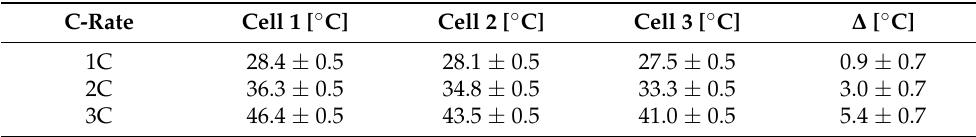
Table 8. Comparison of maximum cell temperatures during the fast charge tests, together with the maximum temperature difference across the module. Results are provided with the uncertainty associated with calibrated T-type thermocouples ( ± 0.5 ◦ C and 0.7 ◦ C for the ∆